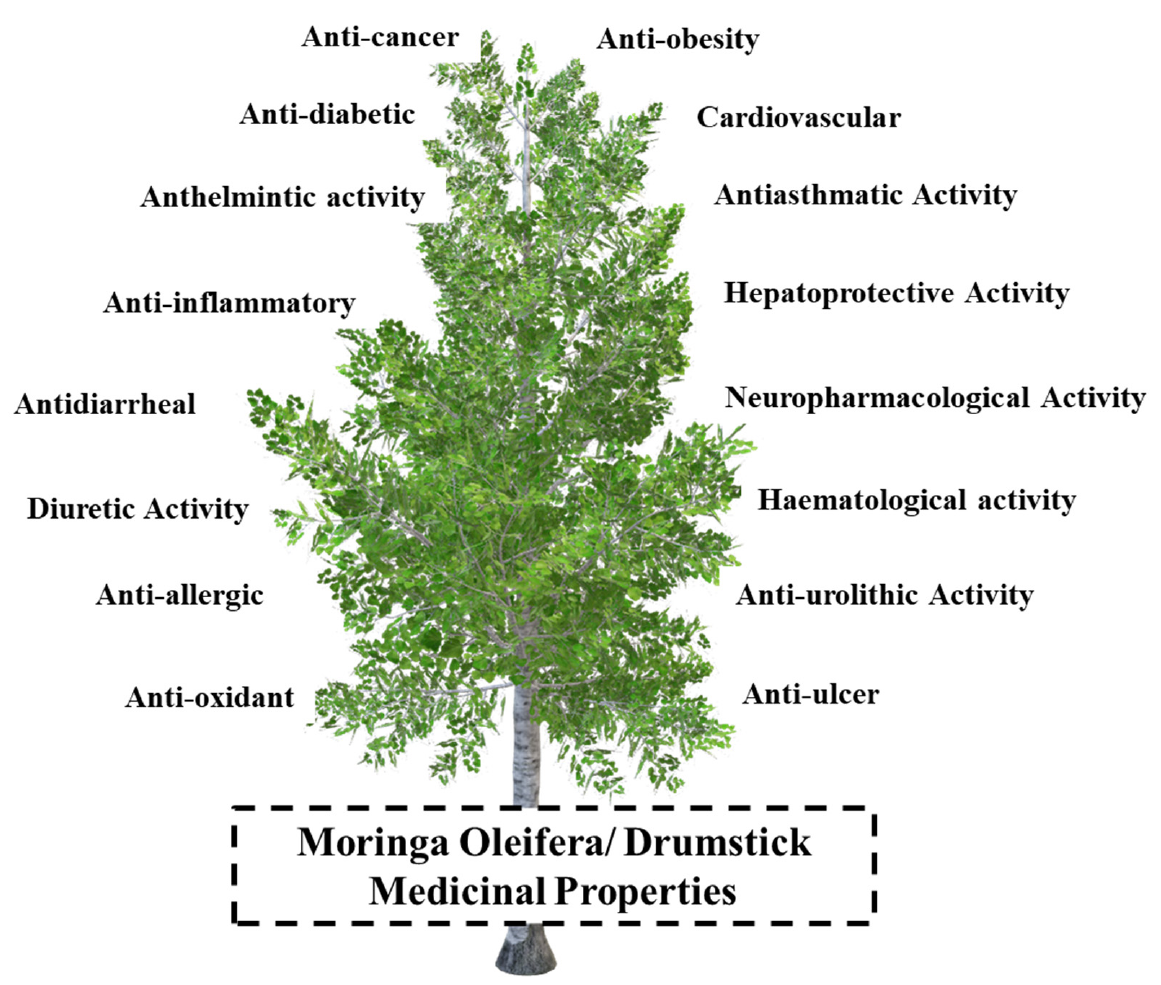
Figure 3. Various medicinal properties of M. oleifera.